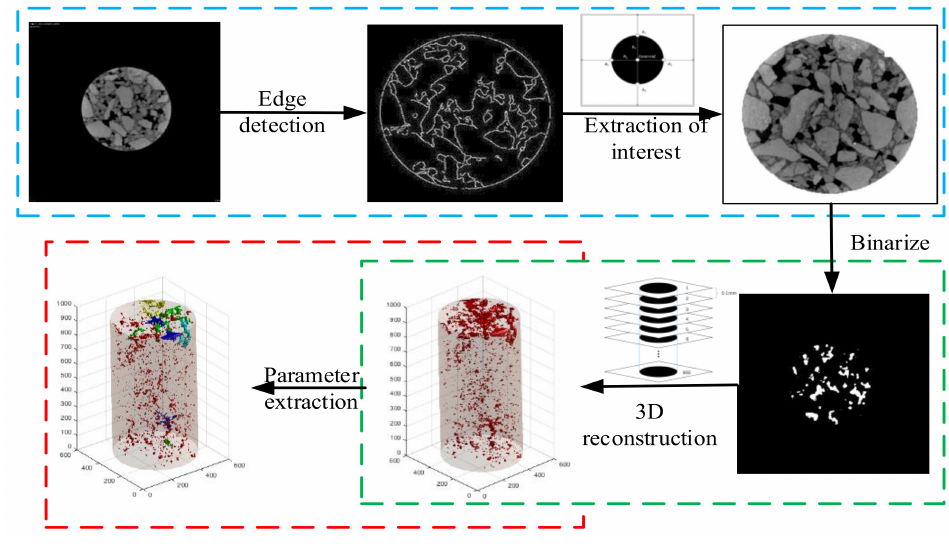
Figure 3. Imaging processing technique [24].